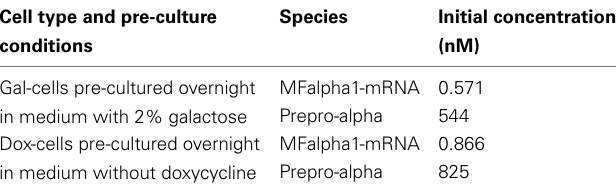
Table 4 | Initial conditions for gal -cells pre-cultured in the presence of 2% galactose and for dox -cells pre-cultured without